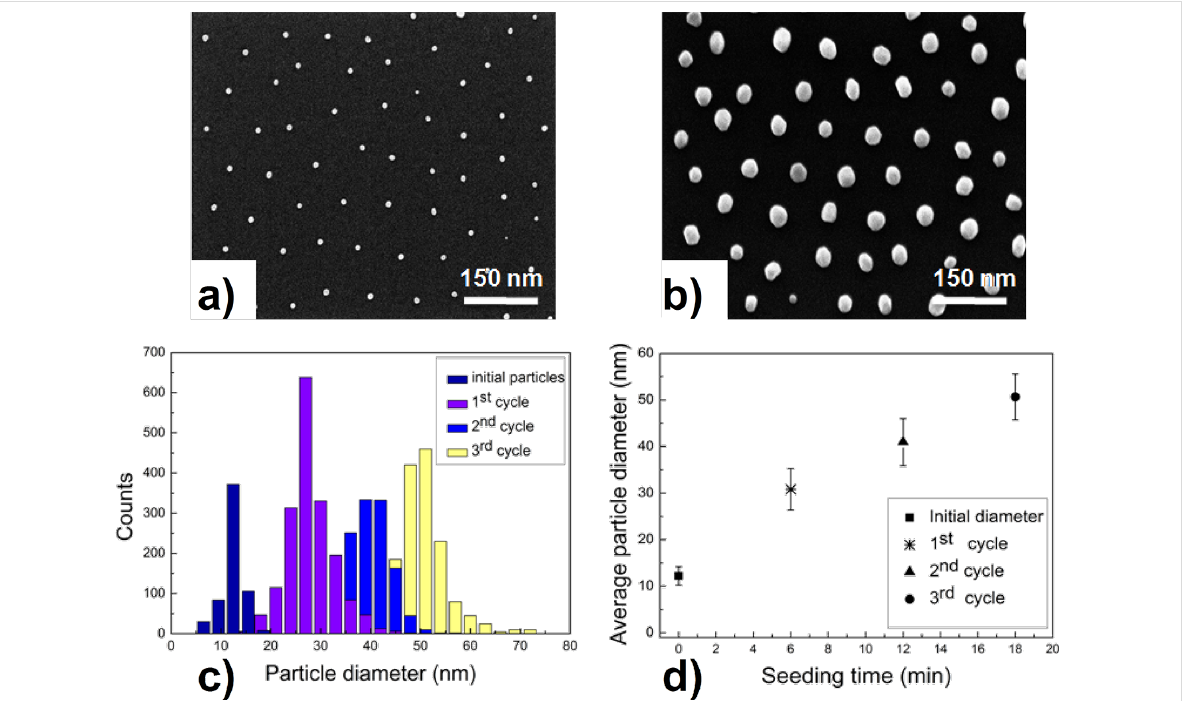
Figure 2: HRSEM images of (a) as prepared Au NP on silica (average diameter 12 nm), (b) Au NP after the second electroless size-enhancement cycle (average diameter 40 nm). Panel (c) presents the size distributions of the seeding steps defined in panel (d), which includes the corresponding seeding times.